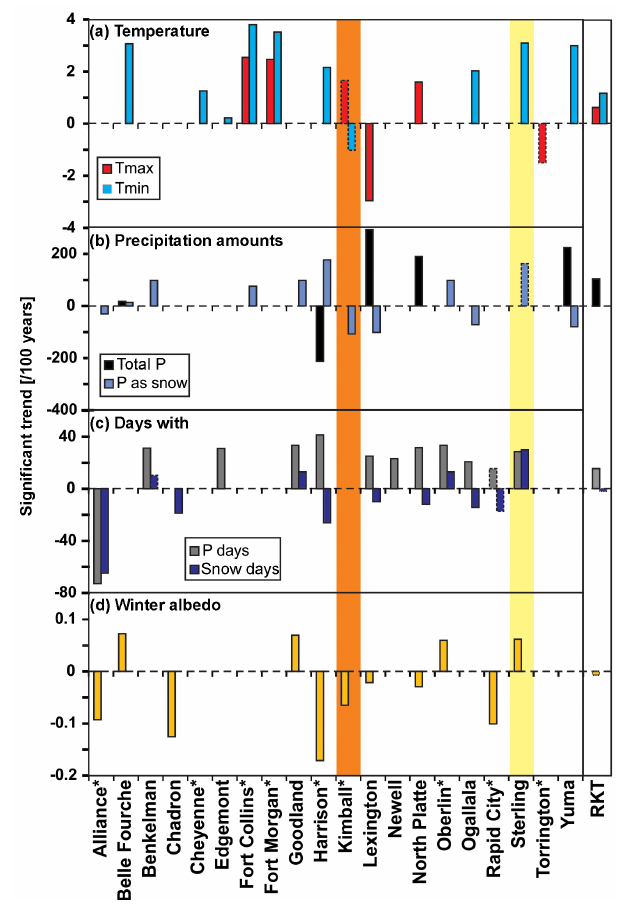
Figure 2. Significant climatic trends at the 20 stations and for the seven variables summarised in Fig. 1 for the period from 1951 to 2010, shown per century. Significant trends are presented at the p < 0.05 level, except for trends shown with a dashed border which are at the p < 0.10 level. Trends from the Regional Kendall test (RKT) are shown on the right. The Sterling, Colorado (yellow), and Kimball, Nebraska (orange), stations are highlighted as they are subsequently compared in Figs. 4 and 5. The nine stations that are part of the U.S. Historical Climate Network (HCN) are identified with an